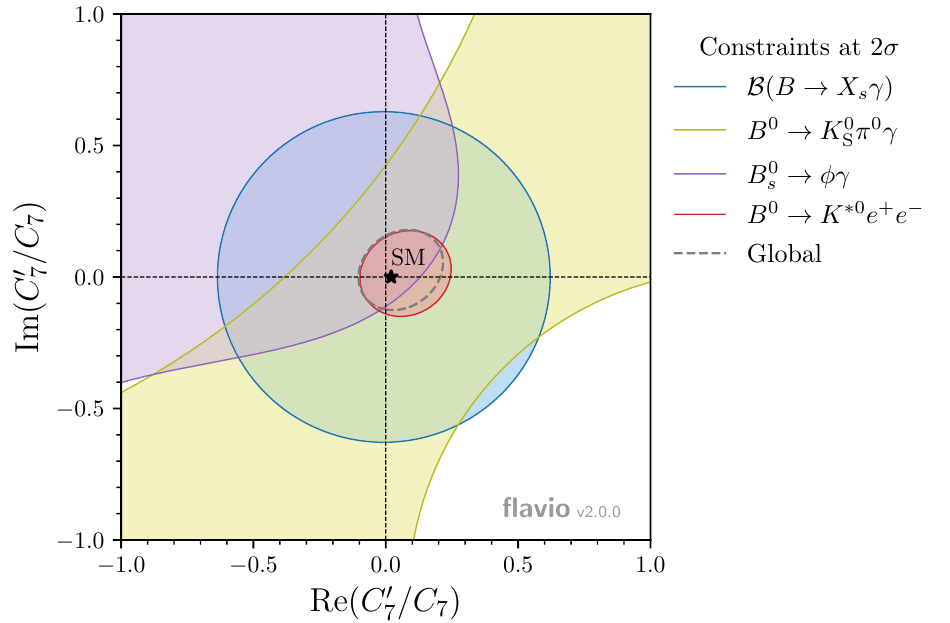
Figure 4 . Constraints at 2 σ level on the real and imaginary parts of the ratio of right- and left-handed Wilson coefficients, C 0 and C 7 . The C 7 coefficient is fixed to its SM value. The 7 measurements of the inclusive branching fraction, B ( B → X s γ ) , and the B 0 → K 0 π 0 γ mixing- S induced CP asymmetry by the Belle and BaBar experiments [11–17] are shown in blue and yellow, respectively, the B 0 → φγ measurements at LHCb [18] in purple and the measurement presented s in this paper in red. The global fit is shown in dashed lines and the SM prediction is represented by a black star and corresponds to the ratio of s - and b -quark